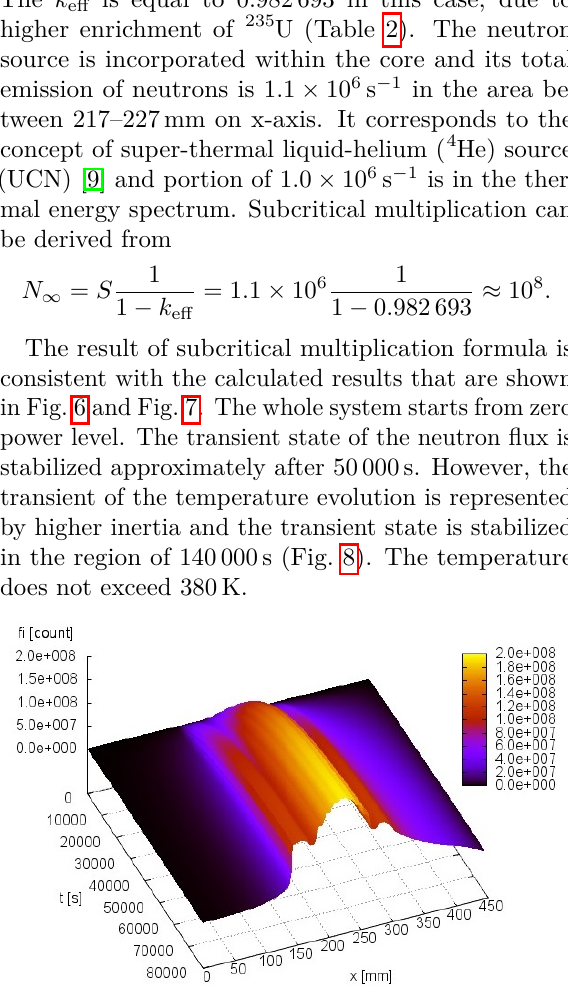
Figure 6. Neutron flux distribution for energy group 0 . 0253 eV in Case 2 (nuclear system is stabilized after subcritical multiplication for k eff = 0 . 982 693).